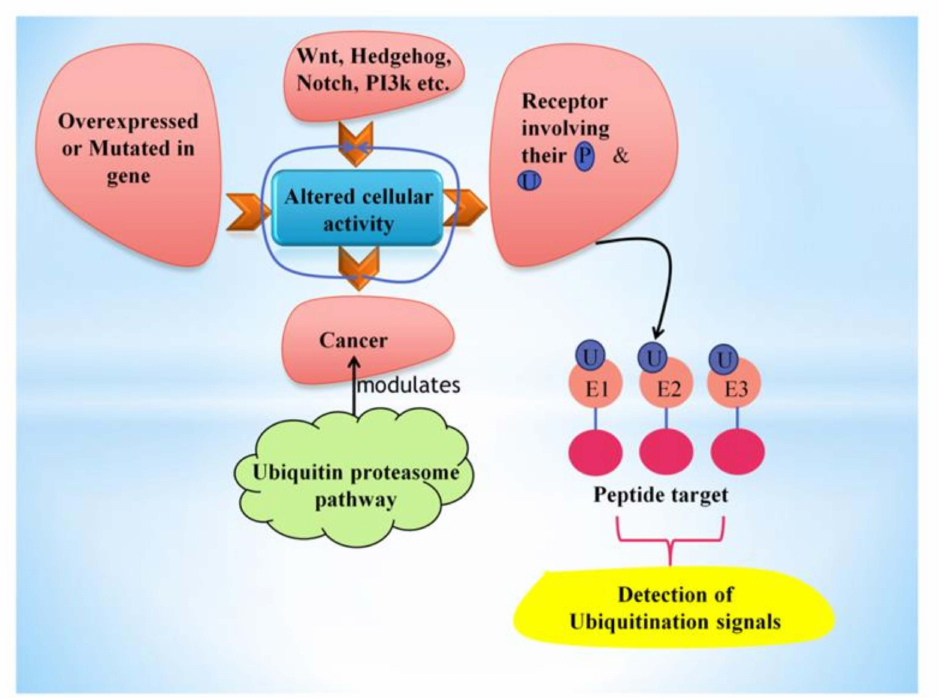
Figure 1. This figure shows the factors leading to the alteration of cellular activity, further causing cancer, which can be inhibited or influenced by the ubiquitin-proteasome pathway. Ubiquitin polymers attach covalently to peptide targets through a three-step (E1 → E2 → E3) conjugation cascade to detect particular ubiquitination